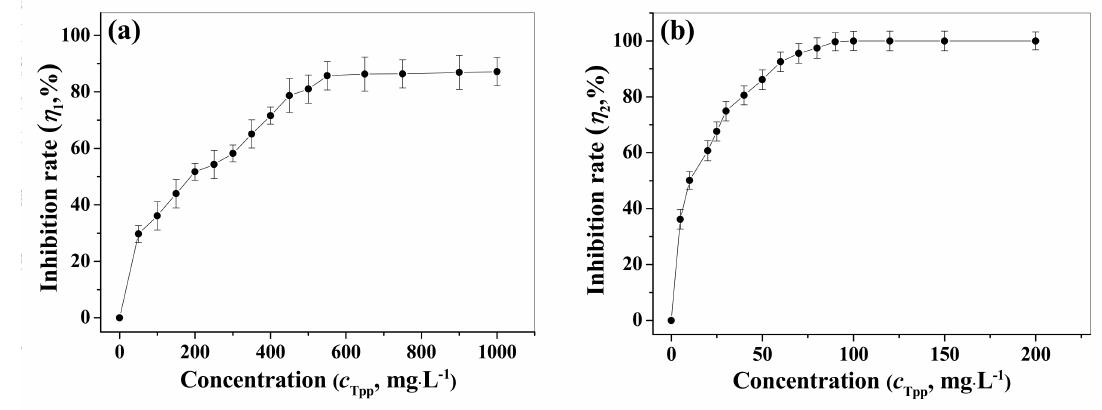
Figure 3. Changes of the corrosion ( a ) and scale ( b ) inhibition rates of TPP during the increasing concentration from 50 to 1000 mg / L and from 5 to 200 mg / L at 60 ◦ C.